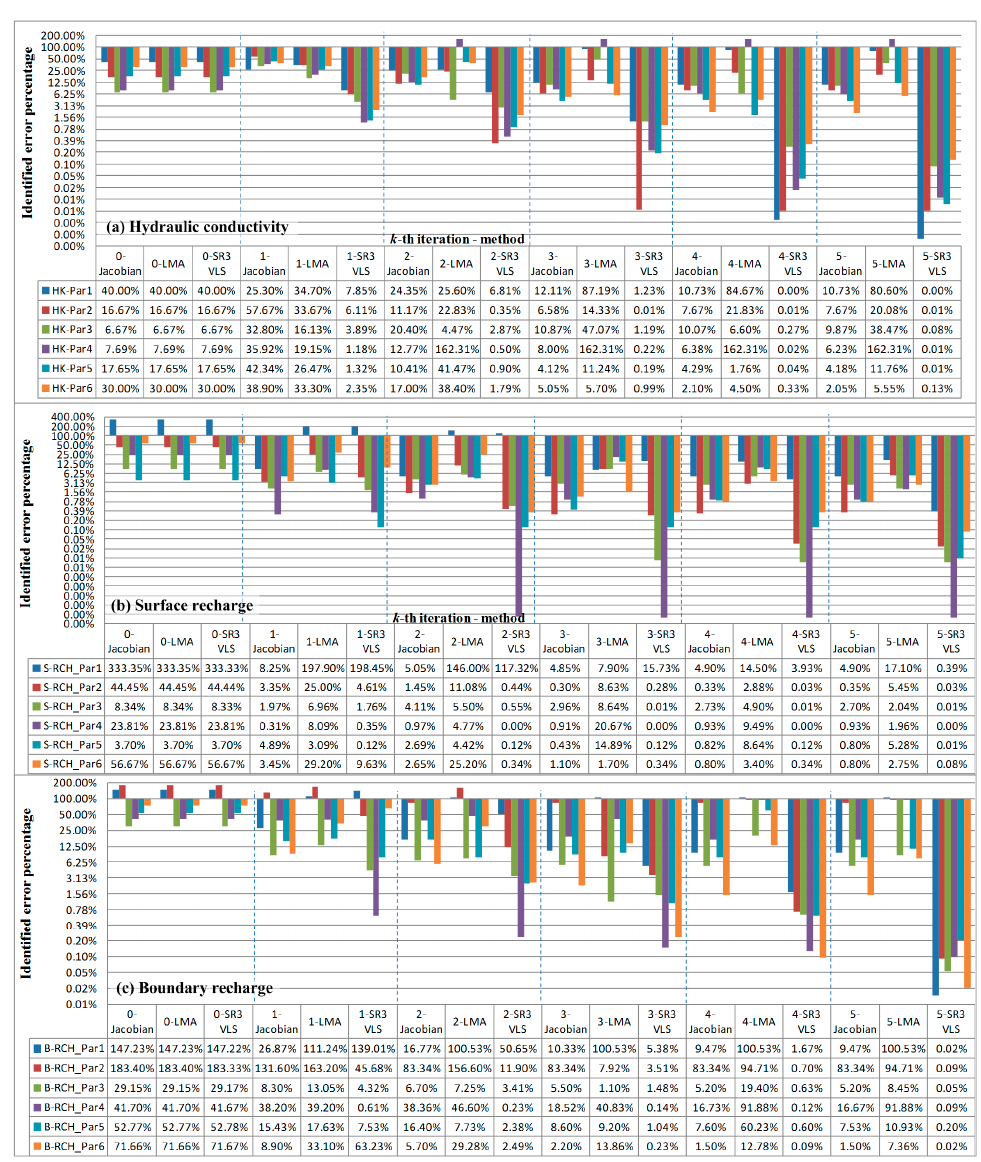
Figure 5. Error percentage of identified hydraulic conductivity ( a ), surface recharge ( b ) and boundary recharge ( c ) during iterations across multiple zones in Experiment 2.